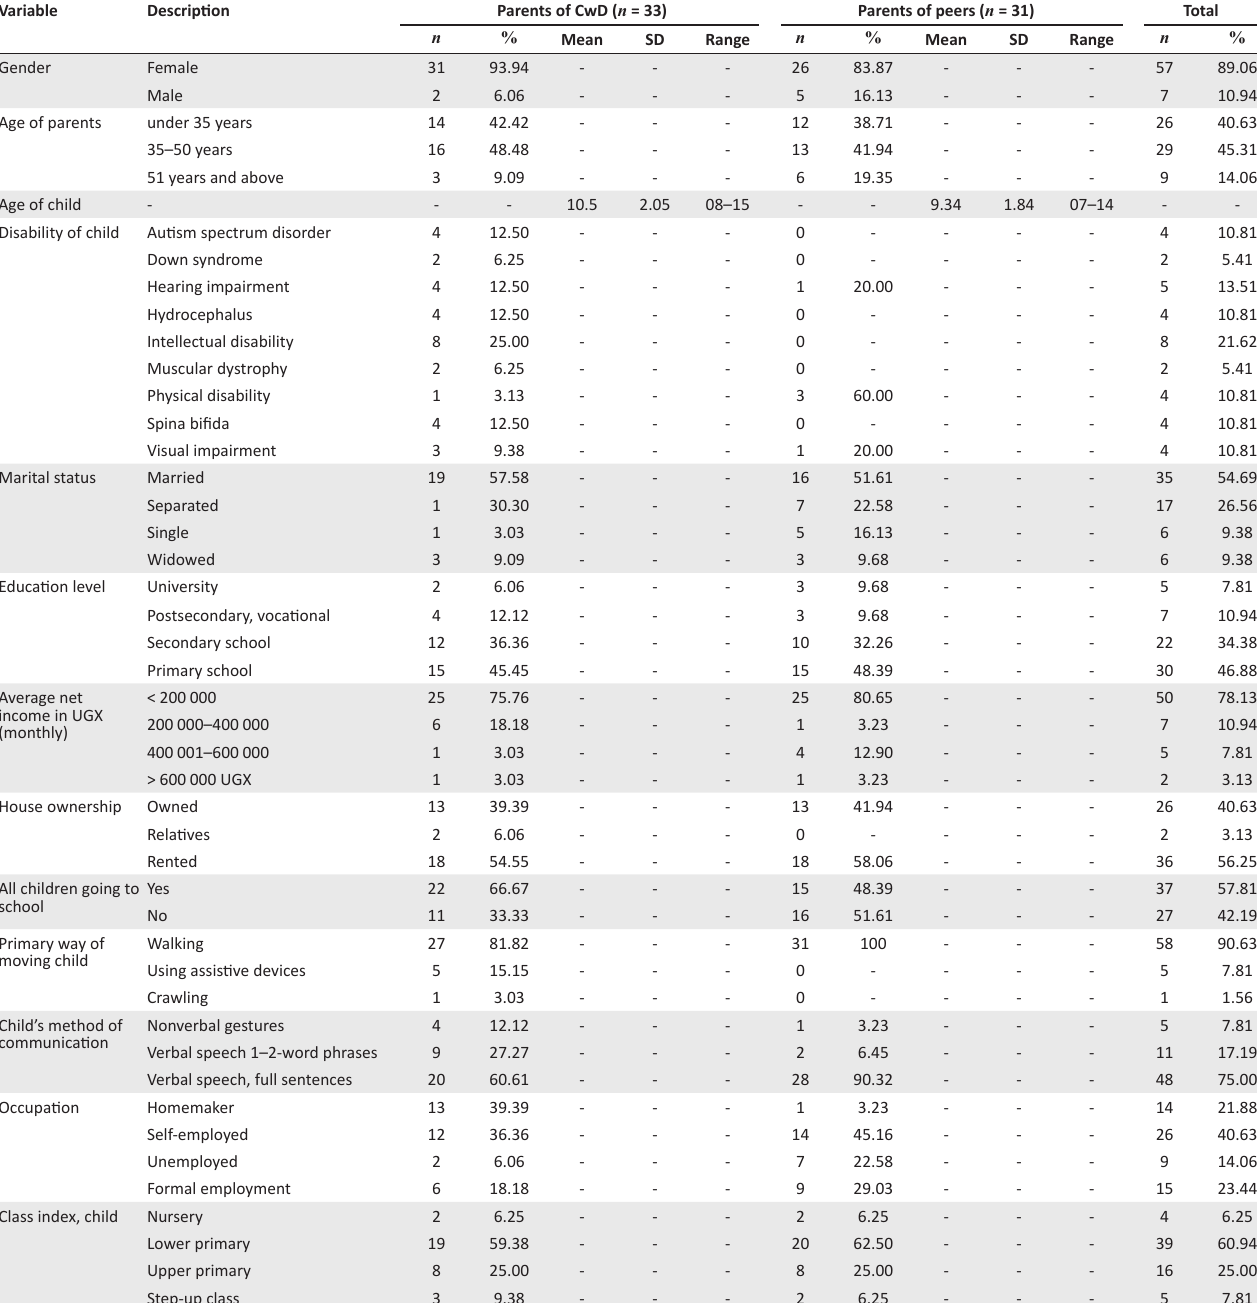
TABLE 2: Demographic characteristics of the participants.